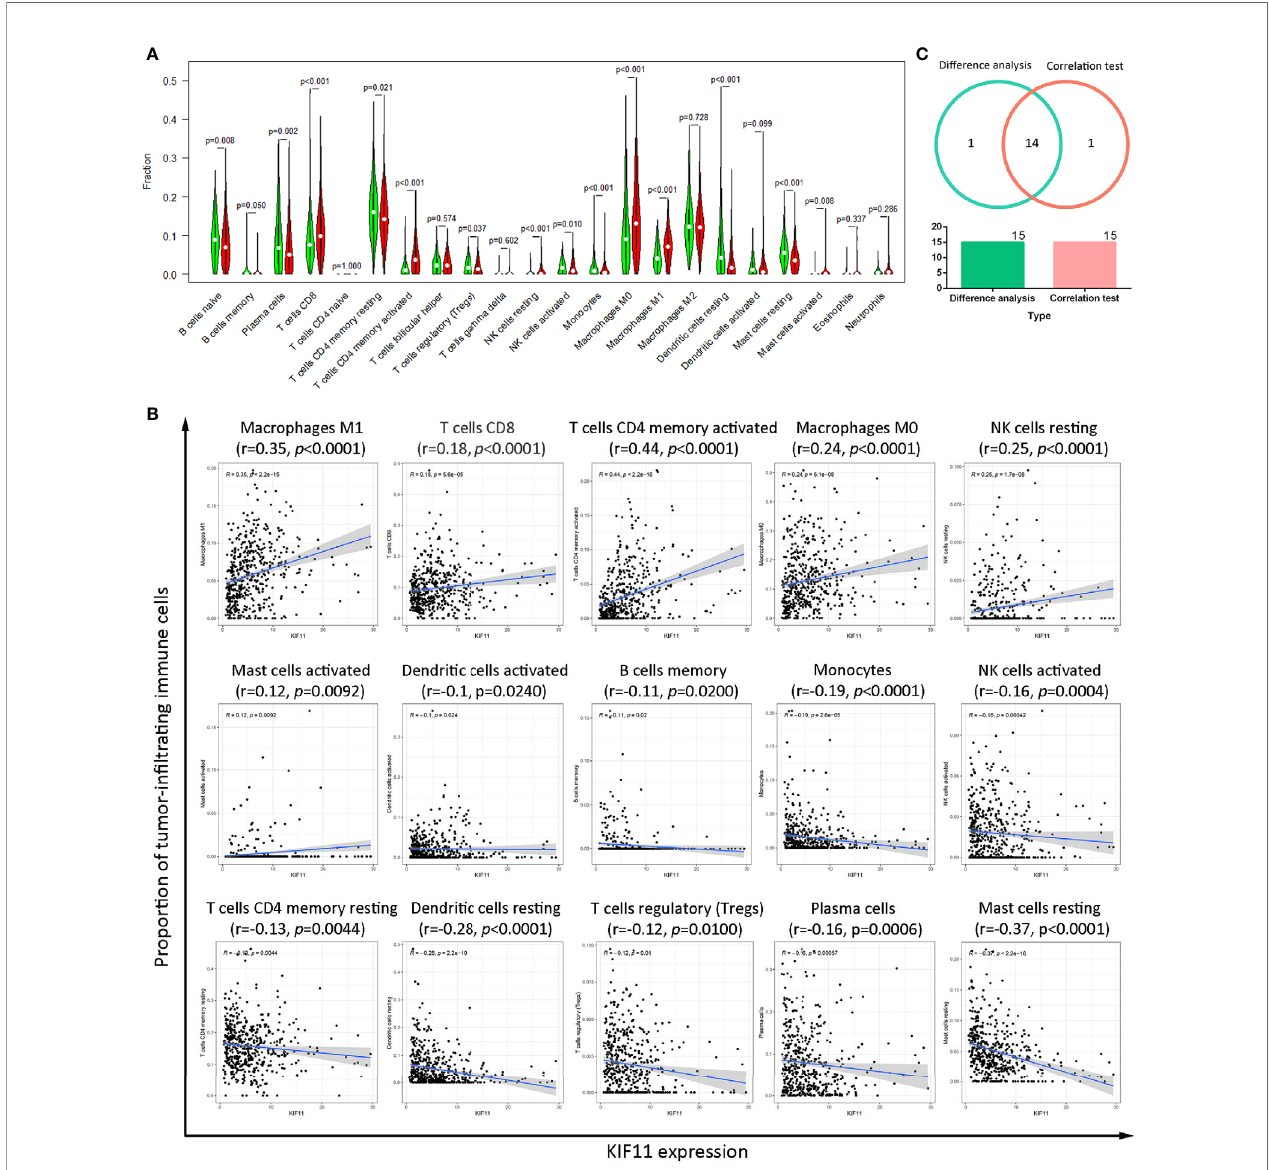
FIGURE 7 | Correlation of the TICs proportions with KIF11 expression. Analysis of differences in 22 TICs proportions between LUAD sample subgroups with high and low KIF11 expression relative to the median KIF11 expression level (A) . Correlation test of the proportions of 15 TICs with KIF11 expression levels (p <0.05) (B) . Venn diagram shows 14 TICs that are correlated with KIF11 expression levels as codetermined by the difference analysis and correlation test (C)